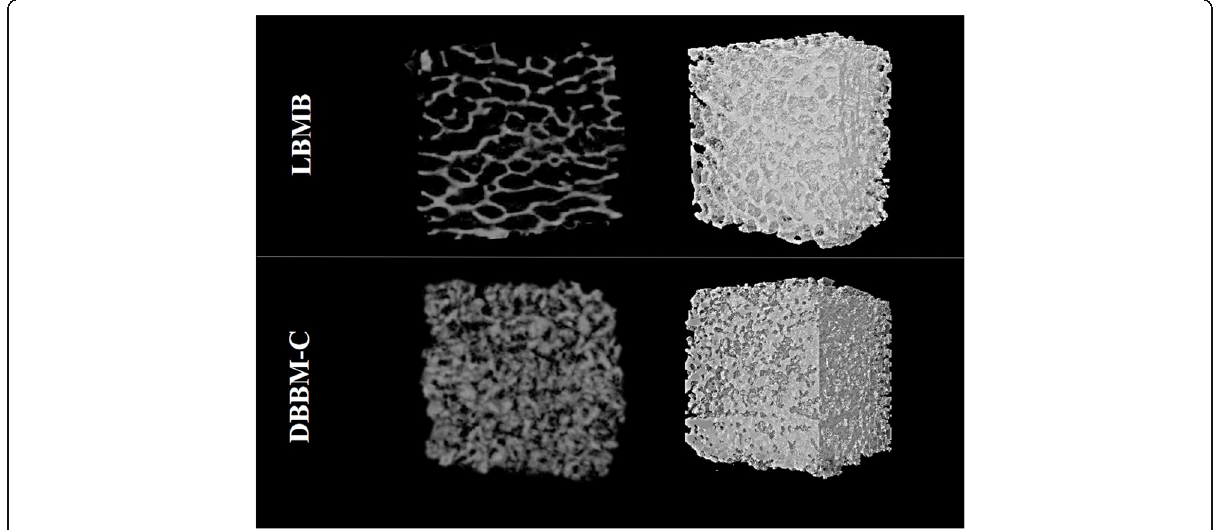
Fig. 2 Micro-CT imaging of deproteinized bovine bone mineral with Collagen (DBBM-C), lyophilized bovine medullary bone (LBMB)